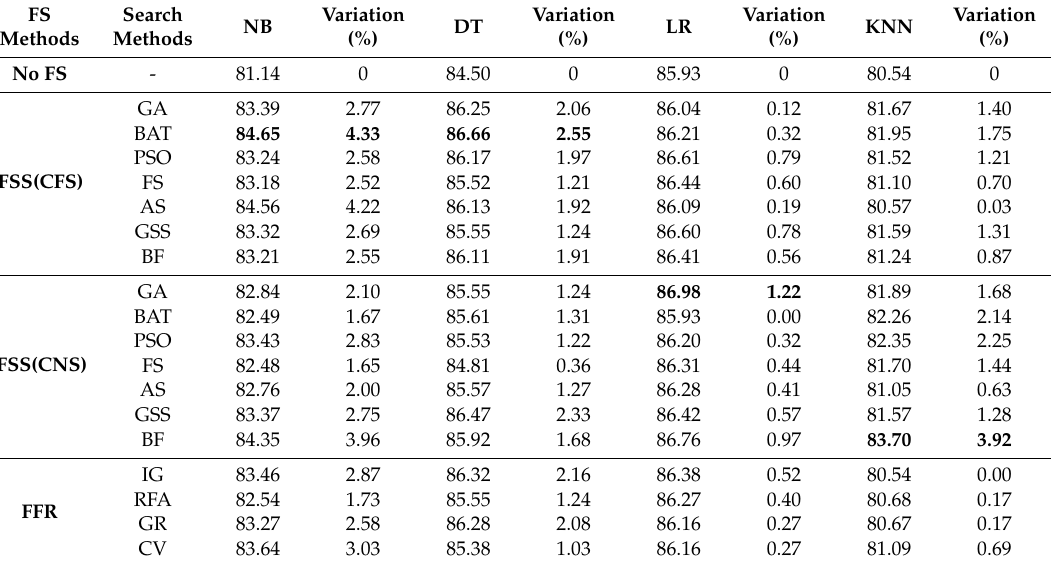
Table 15. Performance (Accuracy) Variation of Prediction Models with di ff erent FS methods.